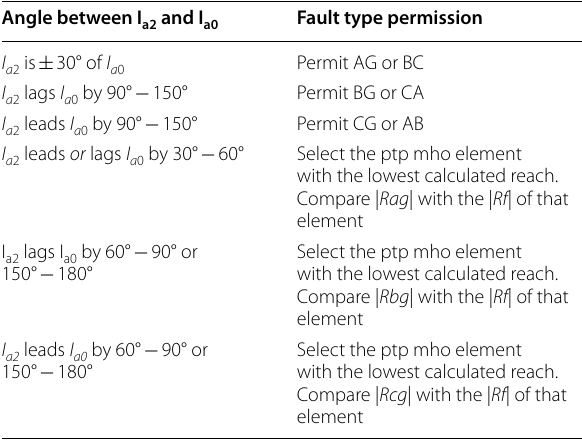
ptp is phase-to-phase, Rag , Rbg , Rcg are A, B, C phase-to-ground fault resistances respectively, and Rf is the fault resistance